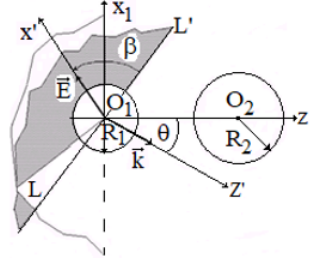
Fig. 1. System of two particles in the electromagnet radiation